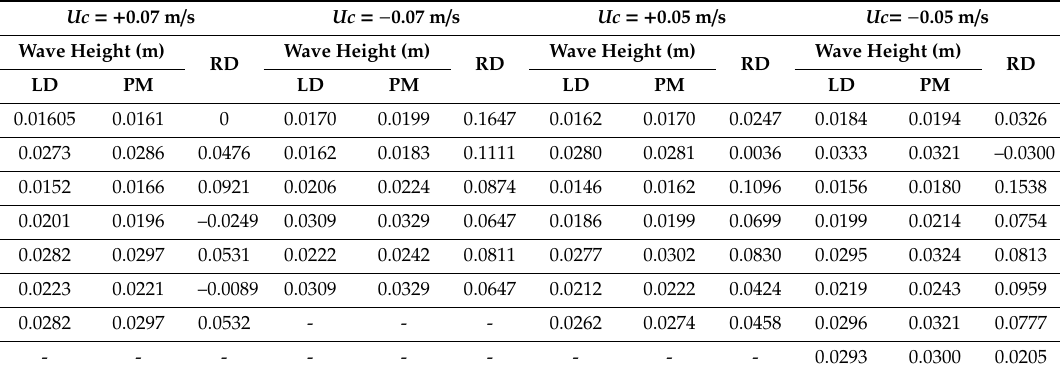
Table A2. Comparison of laboratory data and proposed model outputs of dissipated wave height for co- and counter current cases. LD means Laboratoray Data; PM means Proposed Model; RD means Relative Di ff